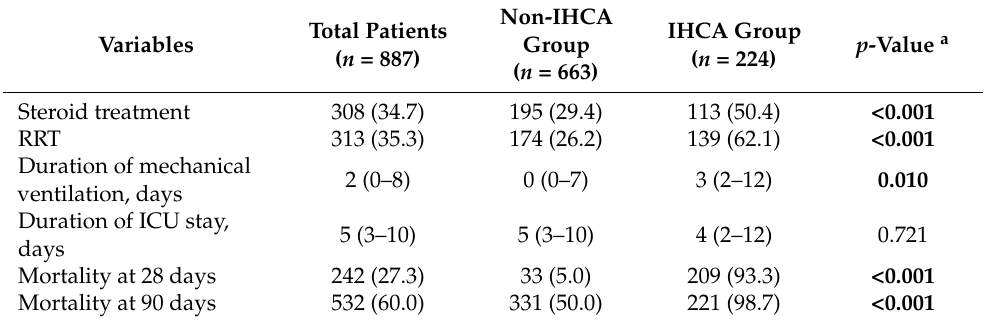
Table 3. Comparison of treatment and clinical outcomes between the IHCA and non-IHCA